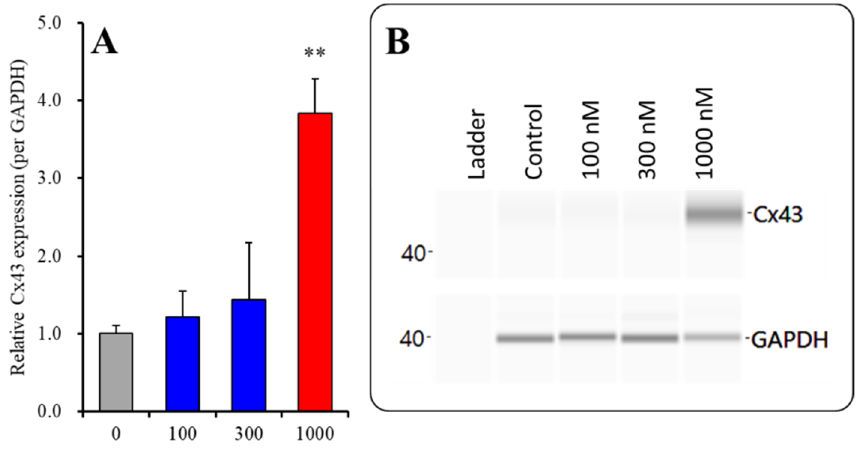
Figure 5. Concentration-dependent effects of subchronic administration of ZTP on Cx43 protein expression in the plasma membrane fraction ( A ) and their pseudogel images, using capillary immunoblotting ( B ). Ordinate: mean ± SD (n = 6) of the relative protein level of Cx43 (per GAPDH). Concentration-dependent effects of ZTP (100, 300 and 1000 nM) on Cx43 expression in the plasma membrane fraction of the primary cultured astrocytes were analysed by one-way ANOVA with Tukey’s (wholly significant difference) post hoc test (** p < 0.01 vs. ZTP free (0)).